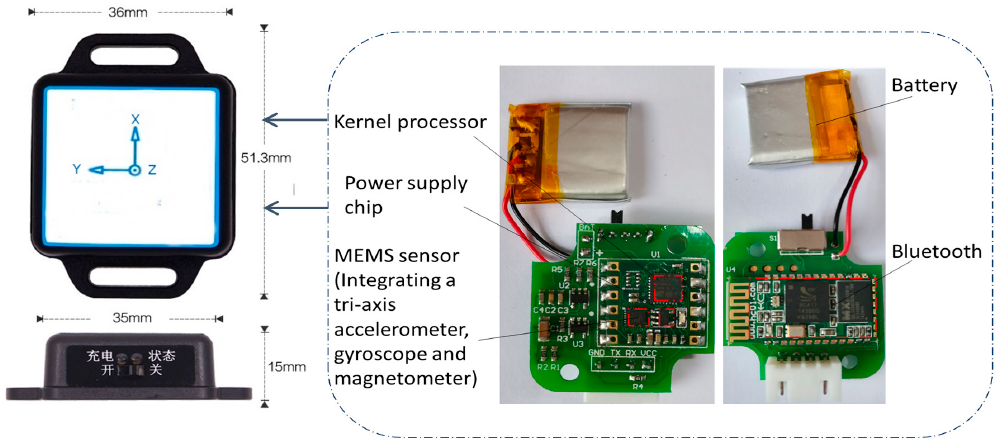
Figure 2. Small, self-packaged sensor unit.